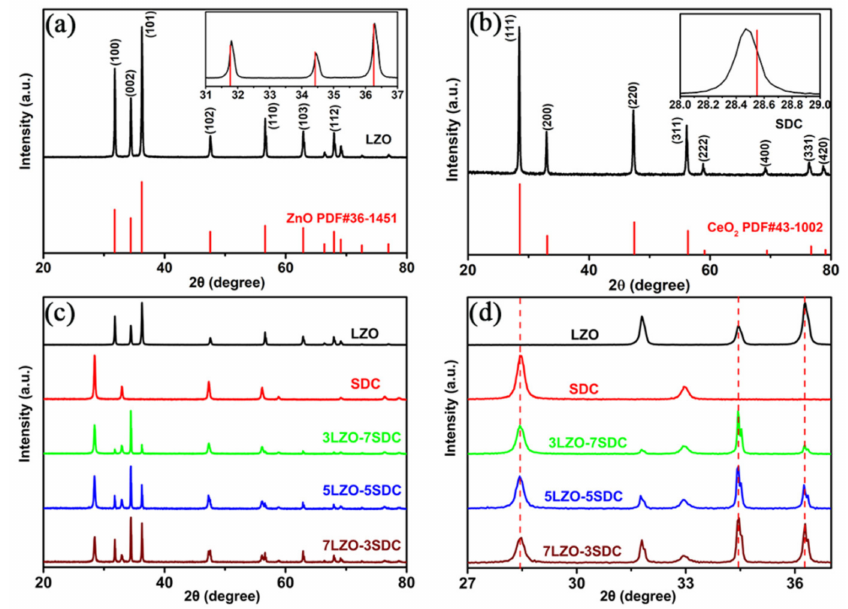
Figure 1. XRD patterns of the prepared ( a ) LZO, ( b ) SDC, and ( c ) LZO-SDC composites; ( d ) Enlarged XRD patterns of the LZO-SDC